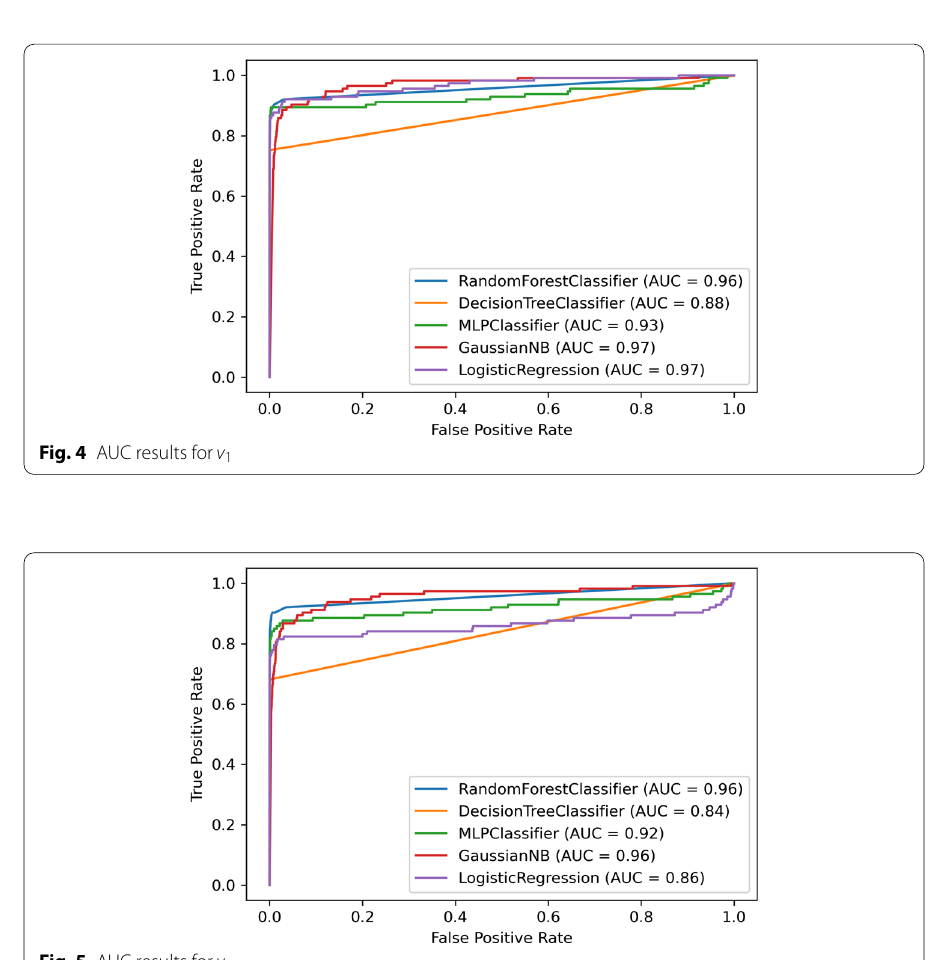
Fig. 5 AUC results for v